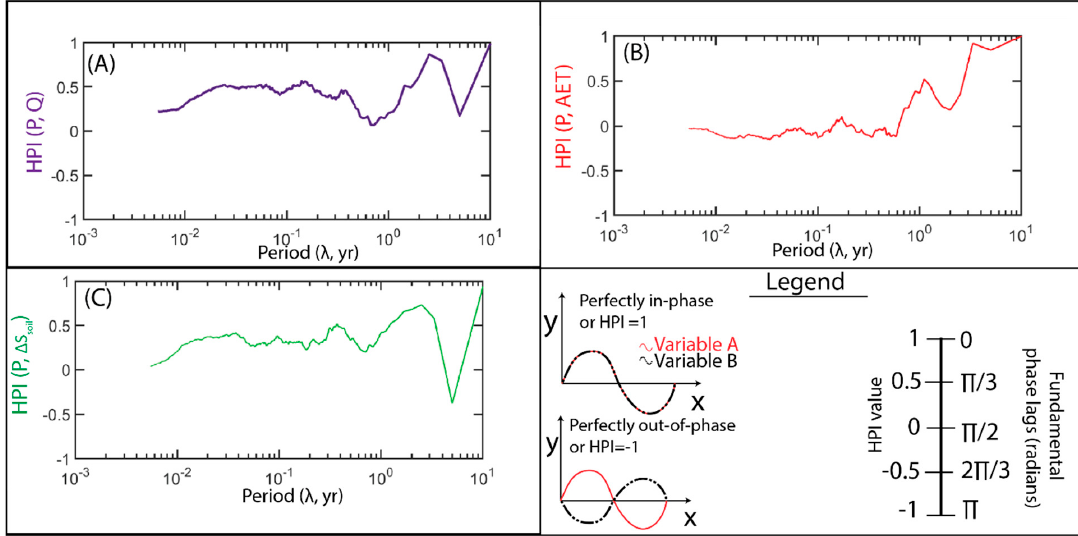
Figure 6. The period-dependent Hydrologic Phase Index (HPI) between precipitation (P) and ( A ) streamflow (Q), ( B ) AET, and ( C ) daily change in soil water storage ( Δ S soil ).